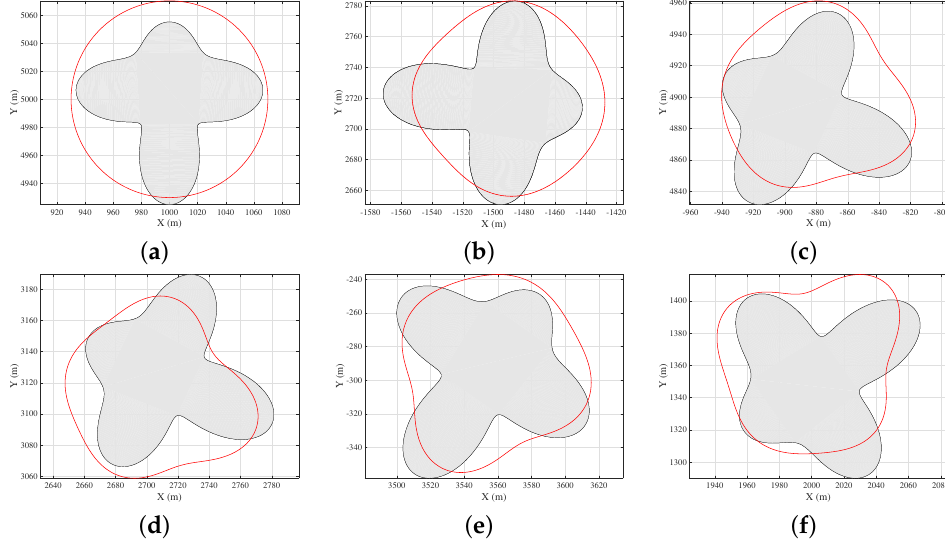
Figure 4. The whole iterative process of shape estimation for star-convex object. ( a ) Step-1. ( b ) Step-20. ( c ) Step-40. ( d ) Step-60. ( e ) Step-80. ( f )